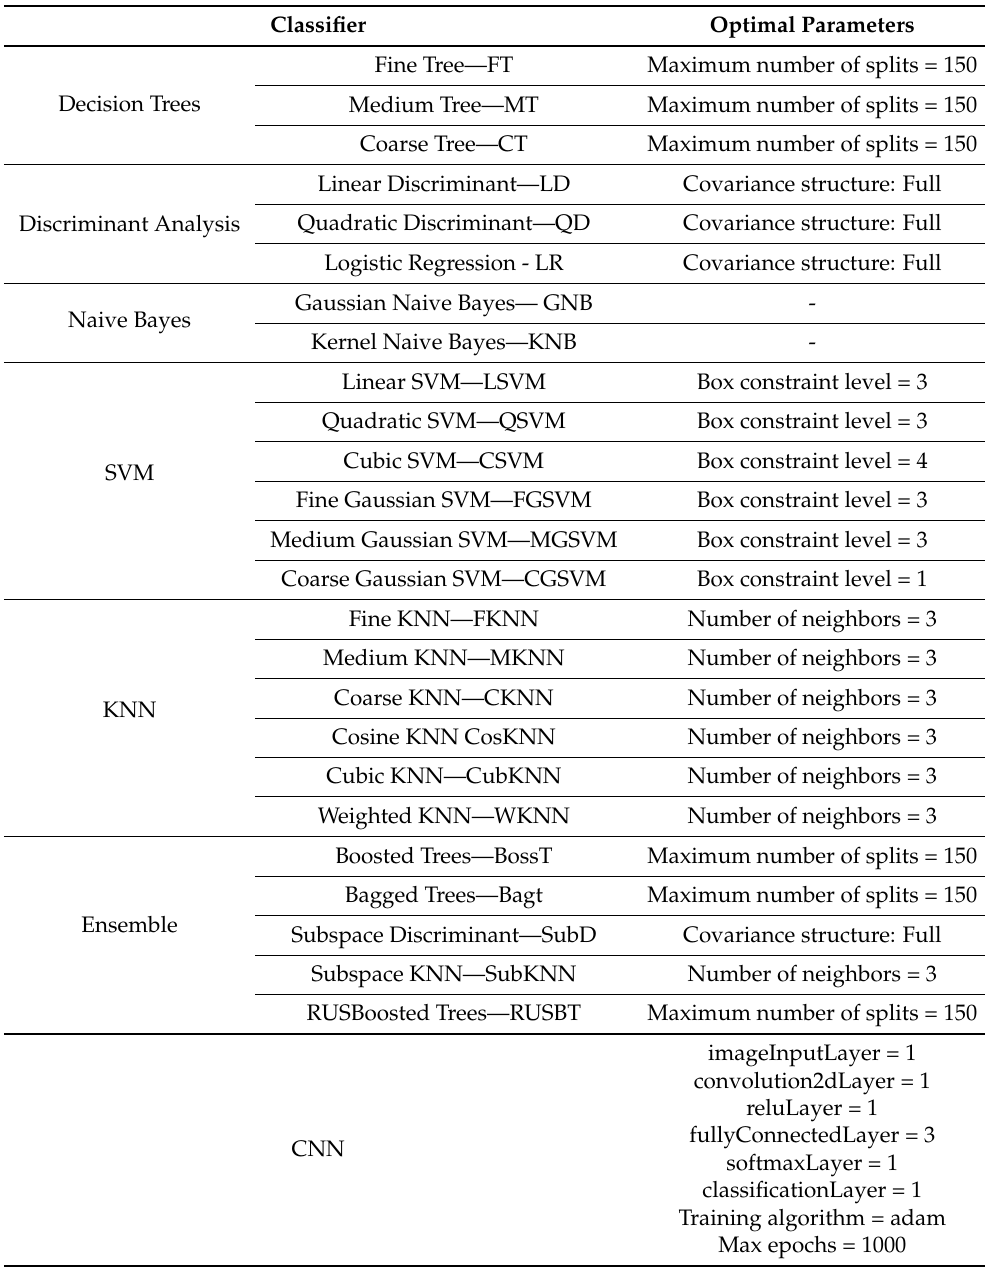
Table 2. Used classifiers and optimal